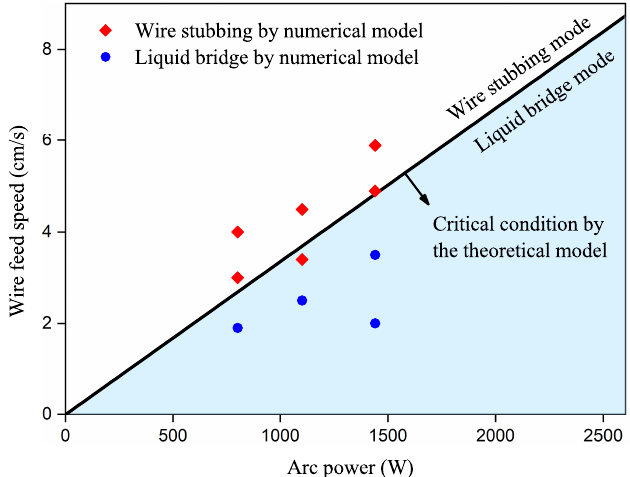
Figure 12. Process parameter window considering liquid bridge–wire stubbing transition.